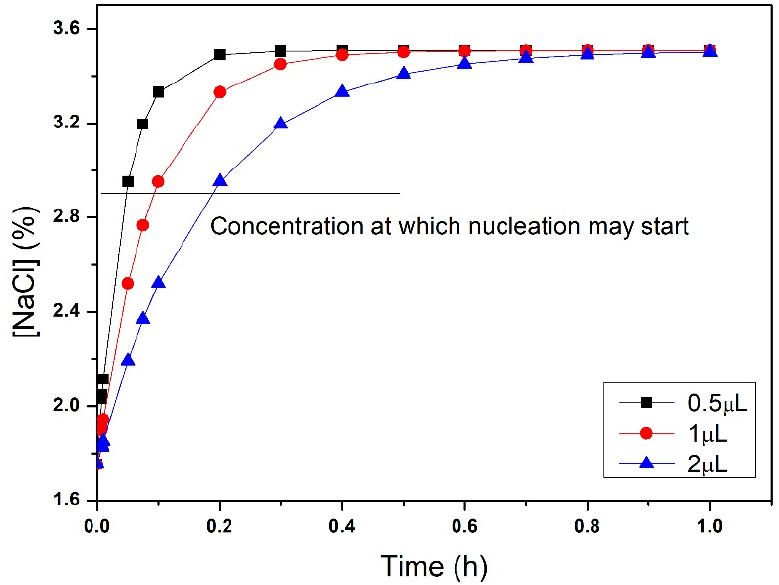
Figure 7. NaCl concentration in the wells of the micro-device over time for different volumes of protein solution.